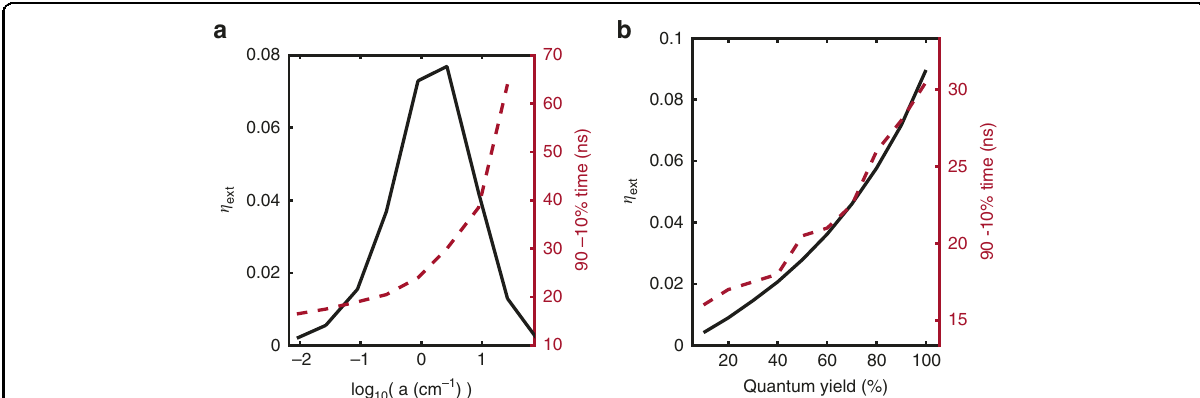
Fig. 5 Effects of luminescent solar concentrator parameters on impulse response. a (Black solid line) simulated external optical ef fi ciency, η ext , as a function of the logarithm of the absorption coef fi cient of the devices for fi xed device parameters. (Red dashed line) simulated fall time of the impulse response of devices as a function of the logarithm of the absorption coef fi cient. b (Black solid line) simulated external optical ef fi ciency, η ext , as a function of quantum yield for a Lumogen Red 305-doped device with fi xed concentration and dimensions. (Red dashed line) simulated fall time of the impulse response as a function of quantum